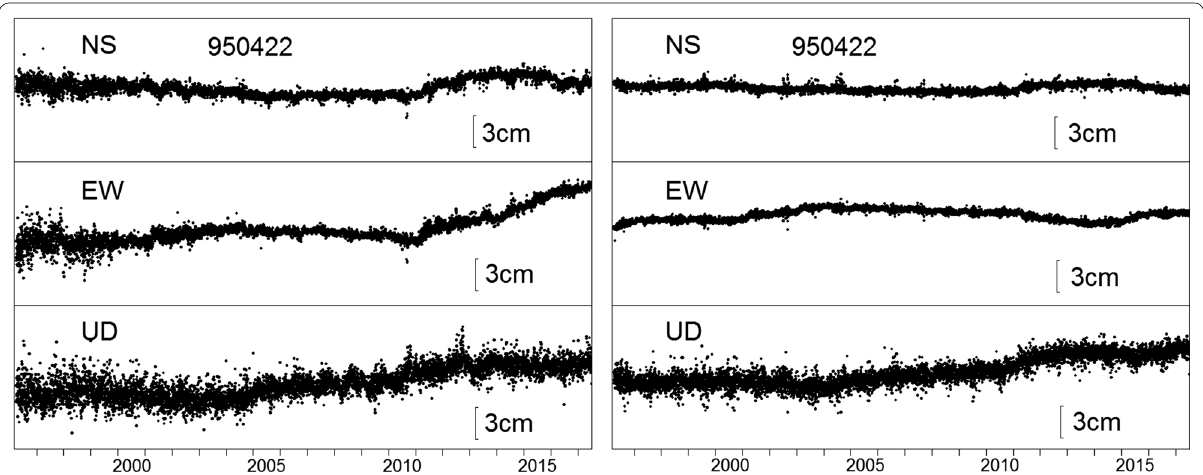
Fig. 2 GNSS daily coordinate time series for station 950422 before (left) and after (right) the common mode error correction. Station location is plotted in Fig.